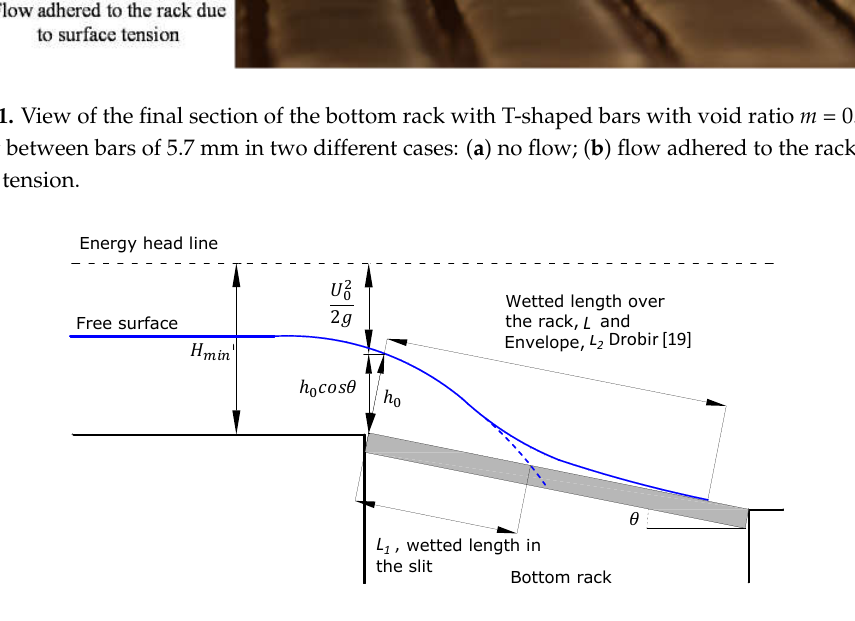
Figure 2. Scheme of the spatially varied flow over bottom intake system.